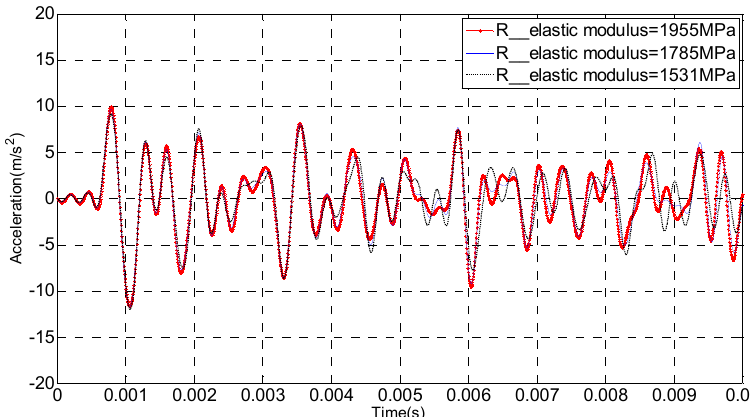
12 of 20 Figure 12. Effect of elastic modulus on wave behaviour in the isotropic material model. Figure 13. Effect of elastic modulus in the longitudinal direction on wave behaviour in the orthotropic material model. For the orthotropic material model, the elastic modulus in the longitudinal direction plays a significant role in changing wave velocity, and the response phenomenon is quite similar to that of the isotropic material model. However, in the radial and tangential directions, the changes of elastic